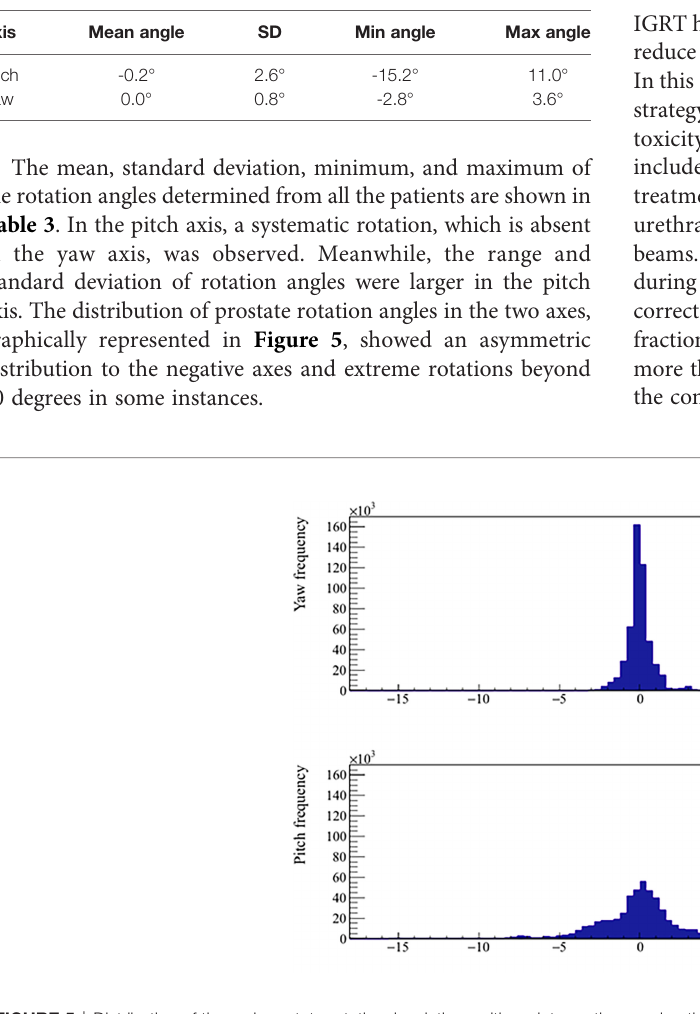
FIGURE 5 | Distribution of the real prostate rotational variations with no interruptions and patient position